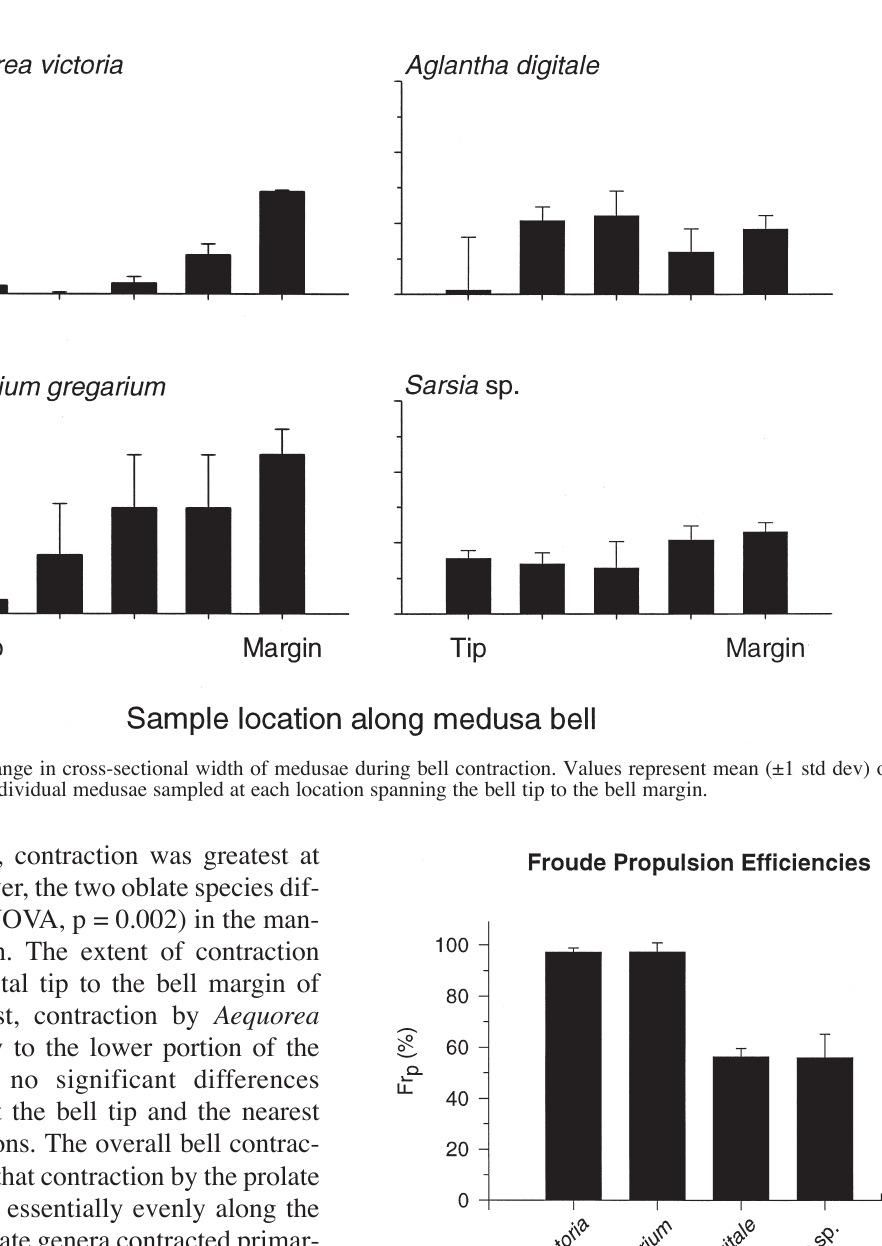
F IG . 5. – Froude propulsion efficiencies (Fr Bars represent the mean of between 10-14 individuals of each species, error bars indicate ±1 standard deviation about the